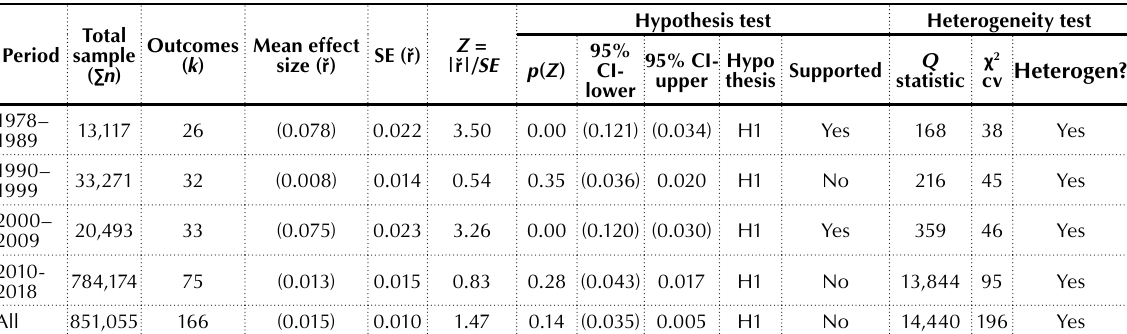
Source: Authors’ calculation.